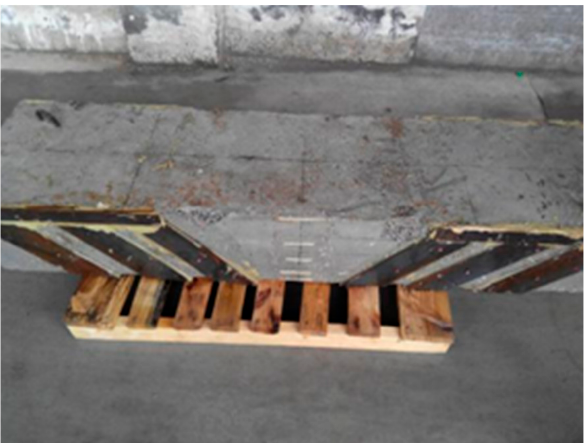
Figure 9. Pasting a carbon fiber cloth reinforced component interface after freeze–thaw erosion.